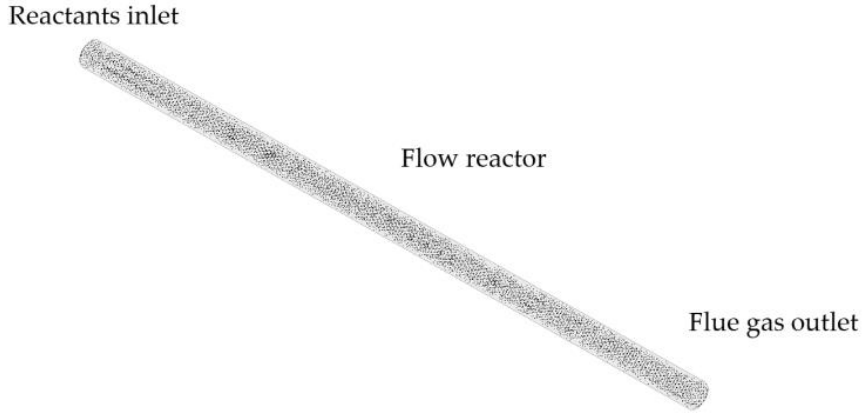
Figure 6. Computational mesh employed to reproduce the experiments of Hulgaard and Kim Dam-Johansen [44].